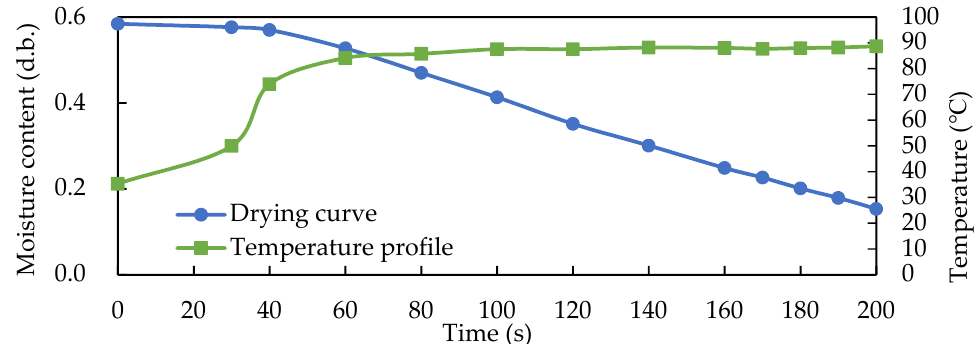
Figure 7. Internal and surface temperature profiles of the solid-state fermented W. cocos products during RF drying with an electrode gap of 15 cm. Data are expressed as mean ± SD ( n = 3).